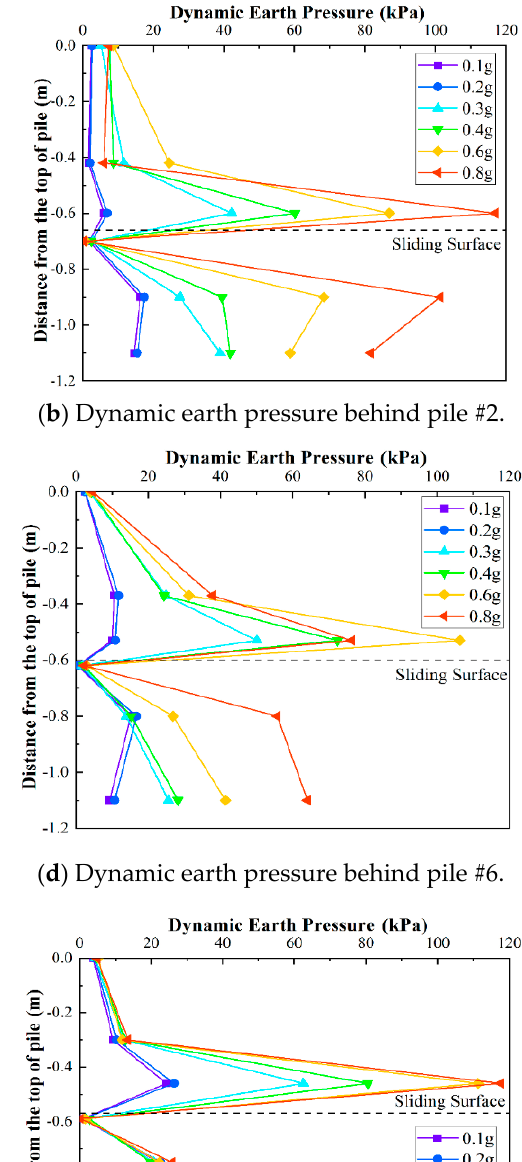
( f ) Earth pressure behind pile #11. Figure 12. Earth pressure distribution in front of and behind each row of piles in the static model tests. It can be seen from the Table 4 that the proportion of piles carried by the rear piles increases initially and then decreases as the load increases with the maximum value (0.411) achieved at 22 kPa. At this time, the ratio of the earth pressure behind each row of piles is back row piles: middle row piles: front row piles = 0.411: 0.348: 0.241. With the further increase in the load, the overall proportion of the middle row piles and the front row piles is slightly larger than under a 22 kPa load. This reveals that the back-row piles are already too deformed, and as such, their load bearing capacity becomes weaker. Mean- while, the front row and the middle row piles play an increased role, and the earth pres- sure triggered by the loading is jointly shared by the front row and the middle row piles. Table 4. The earth pressure sharing ratio of each row of piles (static model test). Loading Location